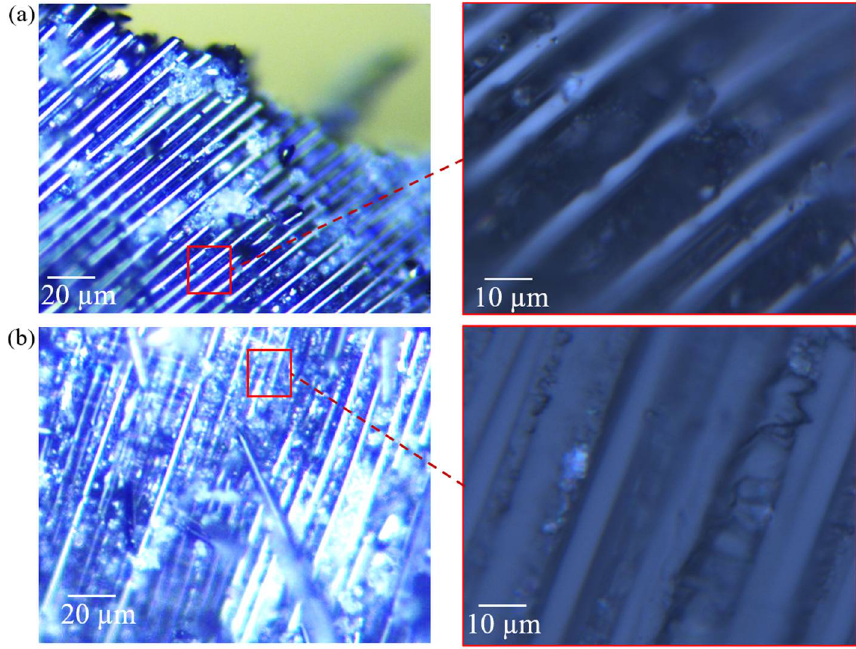
Figure 4. Partial images of crushed composite fragments for ( a ) CFRP-QS and ( b ) CFRP-D. The axial crushing force–displacement curves and force–time curves for CFRP tubes subjected to crushing velocities of 0.00108 m/s and 1.944 m/s are compared in Figure 5. These curves showed similar behavior, with a linear increase in the crushing force to a peak value at a displacement of 12 mm, which correlated well with the chamfer size. The peak force decreased to a plateau level owing to the stress concentration caused by the chamfer. Subsequently, a steady fluctuating force was obtained in the residual proportion, indicating a stable load-carrying process. Table 1 summarizes the crashworthiness indica- tors calculated from Figure 5, including the MCF, EA, and SEA. The MCF and SEA values of CFRP tubes crushed at 1.944 m/s are 485.7 kN and 78.7 kJ/kg, respectively, showing the same 21.8% reduction as those crushed at 0.00108 m/s. This phenomenon is similar to the results of double hat-shaped CFRP tubes in [29], where a reduction of 34.2% appeared after the loading velocity increased from 6 mm/min to 5 m/s. This can be attributed to the differences in the energy absorption mechanisms under different crushing velocities. A detailed analysis is presented in Section 3.4. In addition, SEA values for thin-walled CFRP tubes subjected to quasi-static loads often range between 50.4 kJ/kg and 86.3 kJ/kg [1,26,29,61], which are smaller than the values in this study.